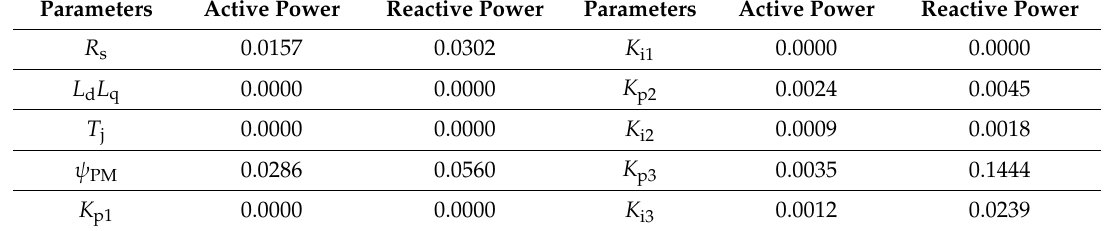
Table 3. Average trajectory sensitivity of parameters when voltage dips about 30%.